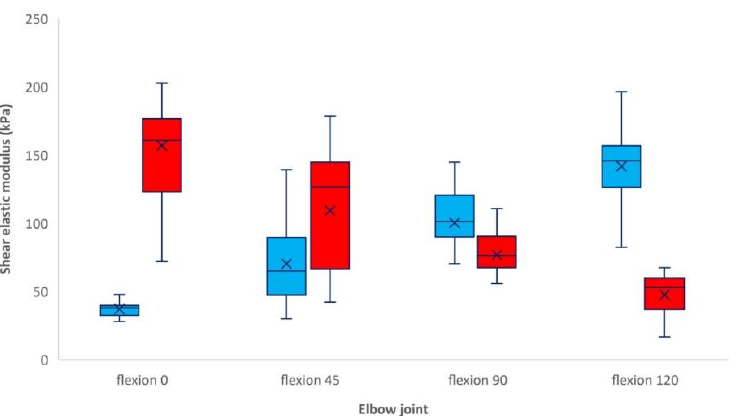
Figure 3. Box plot of the shear elastic modulus of the ulnar nerve (kPa) at 0, 45, 90 and 120 degrees of elbow flexion in operative side (red) and non-operative side (blue). Box (interquartile range (IQR); 75th – 25th percentile), central line (median; 50th percentile), lower whisker (5th percentile), upper whisker (95th percentile).